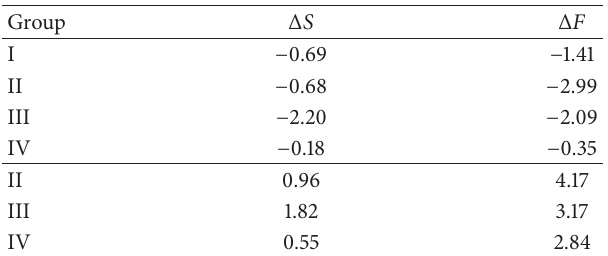
Table 3: Mytilus edulis . Salinity changing rates ( Δ𝑆 ) and simultane- ous filtration changing rates ( Δ𝐹 ) of mussels in all experiments (see Table 2 and Figure